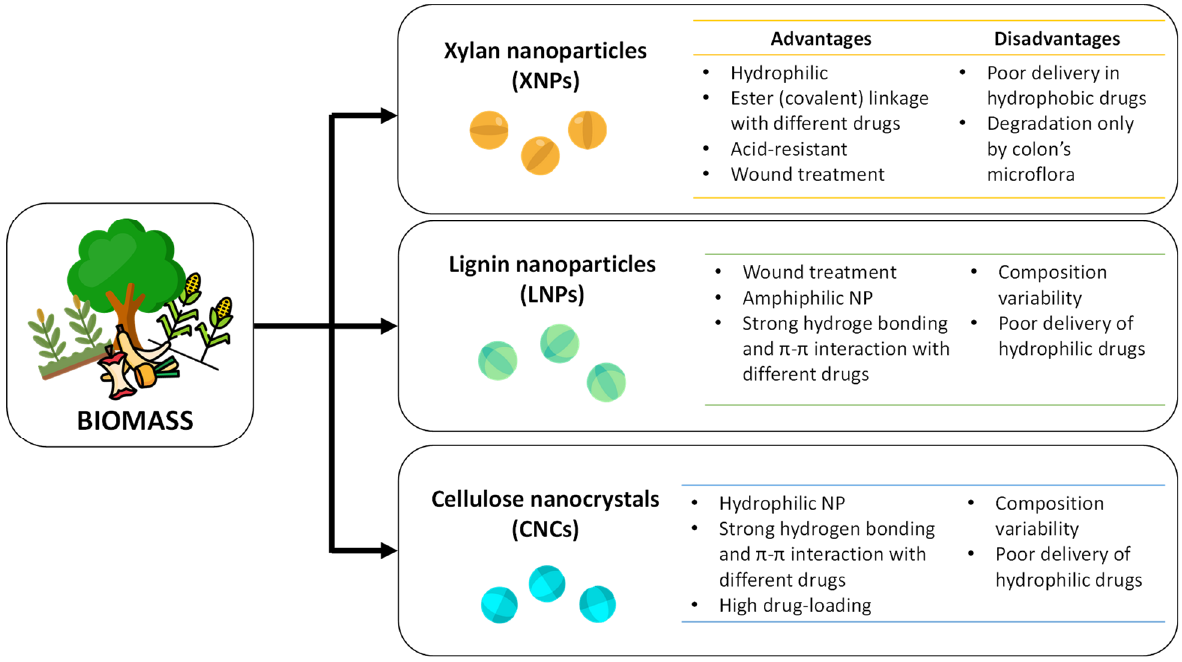
Figure 2. Pros and cons of the most common biomass‑derived nanoparticles.